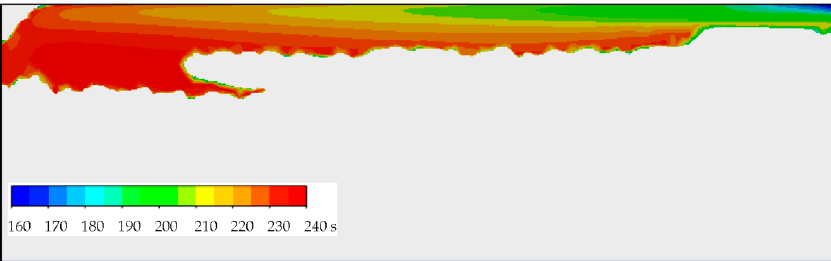
Figure 15. Map of activation times for experiment #17 (after 240 s of simulation).